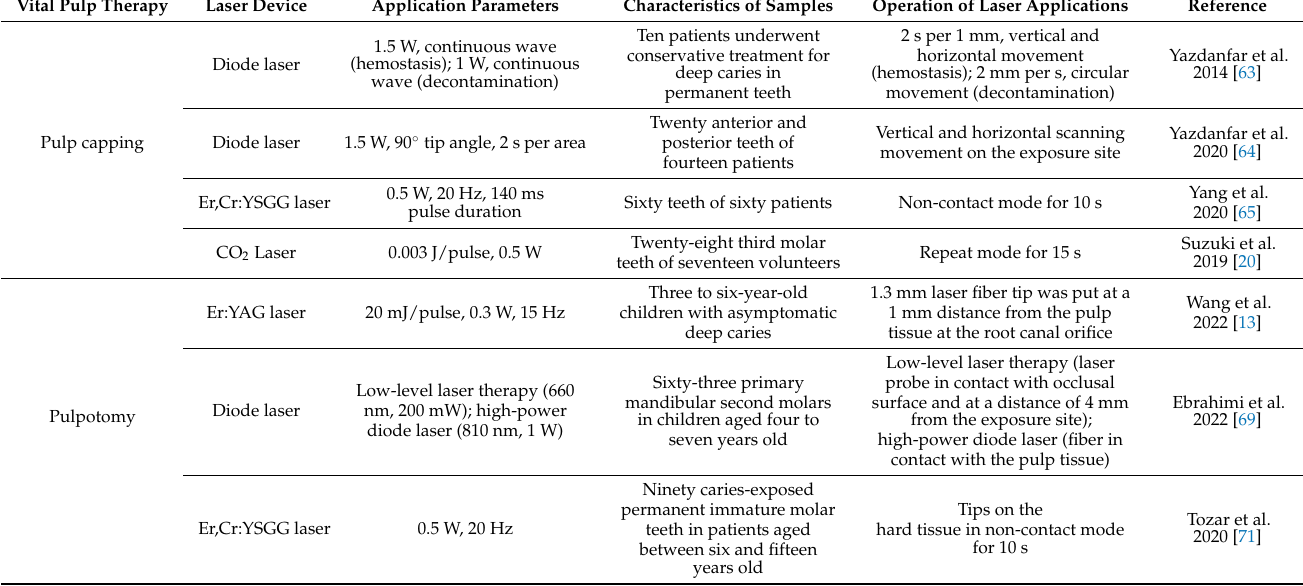
Table 3. Clinical trials on the application of lasers in vital pulp